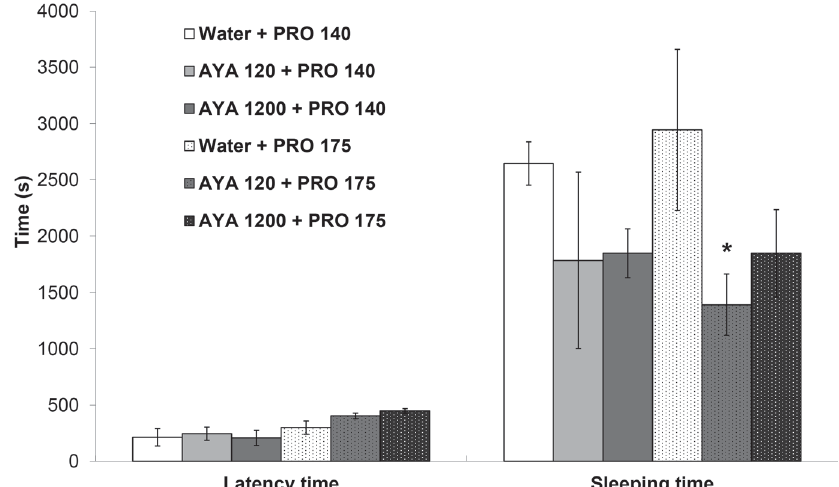
FIGURE 2 - Effect of ayahuasca (AYA, 120 and 1200 mg/kg, p.o.) on the latency time and sleeping time produced by propofol (PRO, 140 and 175 mg/kg, i.p.) in mice. Results are expressed as the mean ± SEM (n=7-10). (*) p <0.05: statistically different from group water + propofol 175 mg/kg. ANOVA followed by Duncan’s